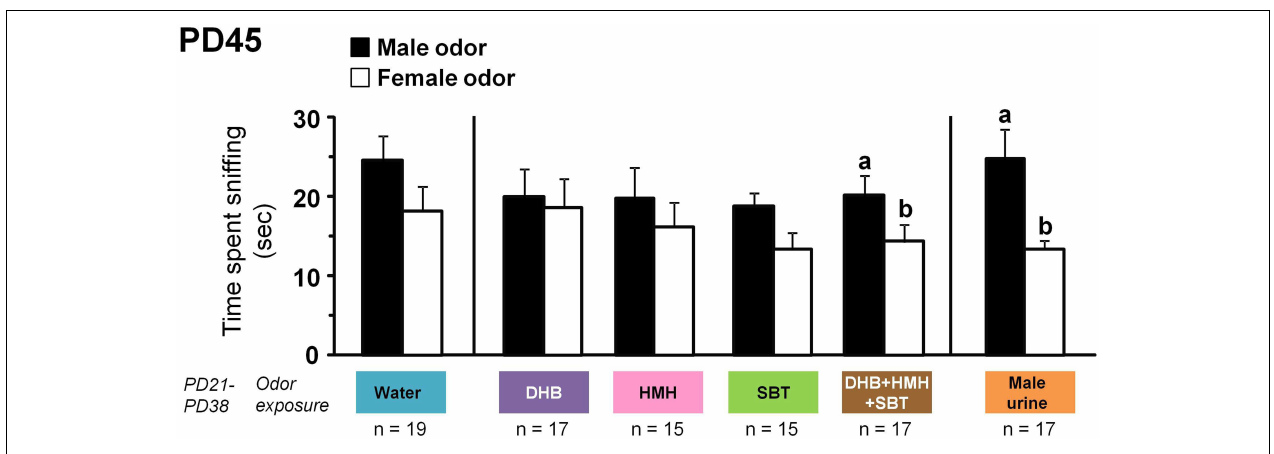
by female Swiss mice exposed to water, DHB, HMH, SBT, a mixture of DHB + HMH + SBT or male urine from PD21 to PD38. Dissimilar letters indicate significant differences, p < 0 . 05 using paired t